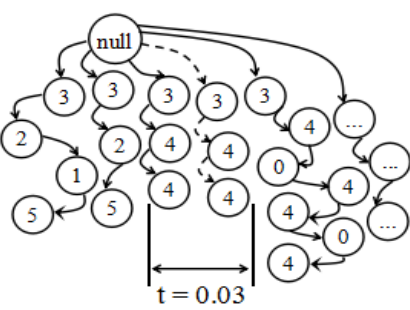
Figure 6. Entropy - based Frequent Pattern (FP) tree for EEG . Figure 6. Entropy-based Frequent Pattern (FP) tree for